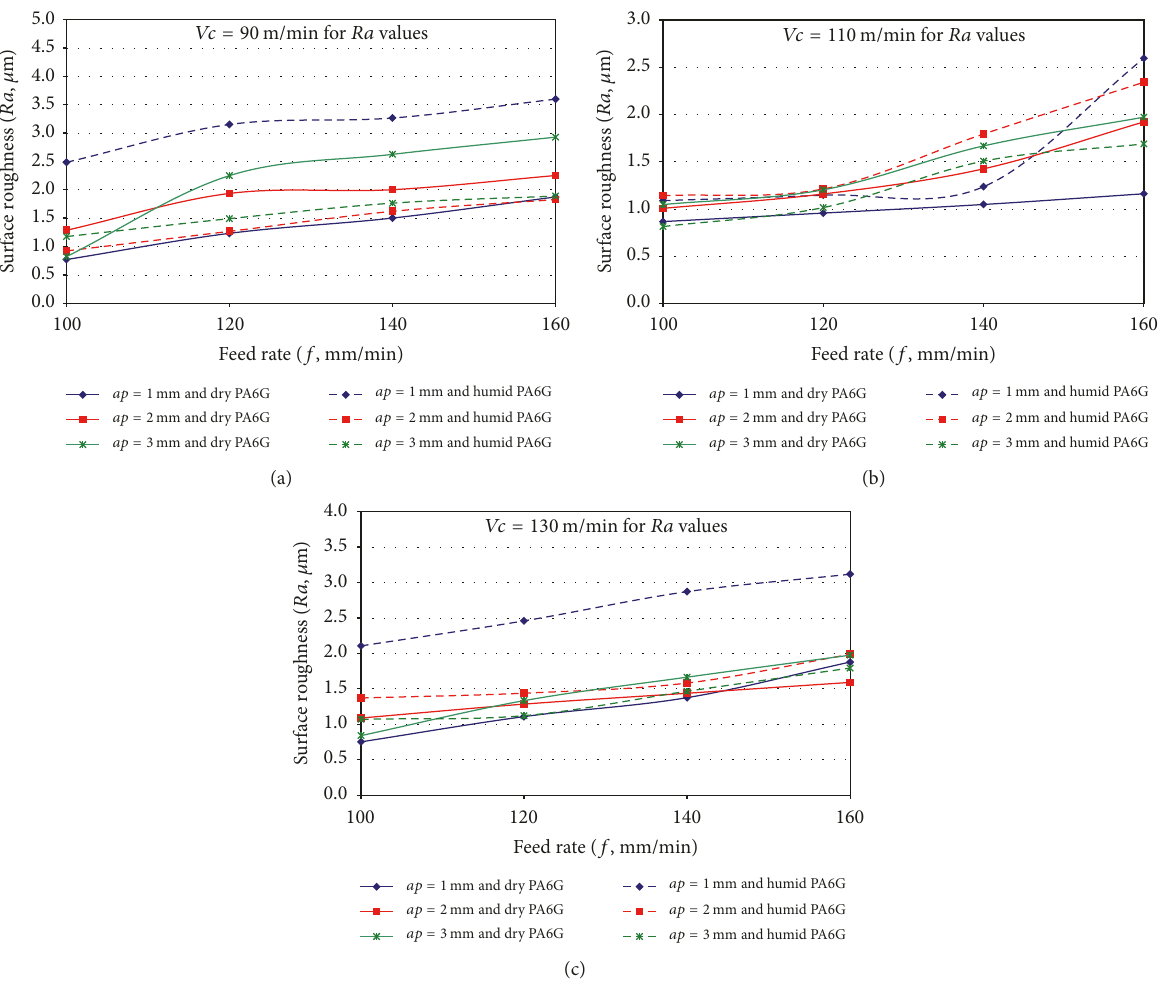
Figure 4: The progress of the average surface roughness formation in different cutting speeds for humid and dry materials: (a) 𝑉 𝑐 = 90m/min, (b) 𝑉 𝑐 = 110m/min, and (c) 𝑉 𝑐 =